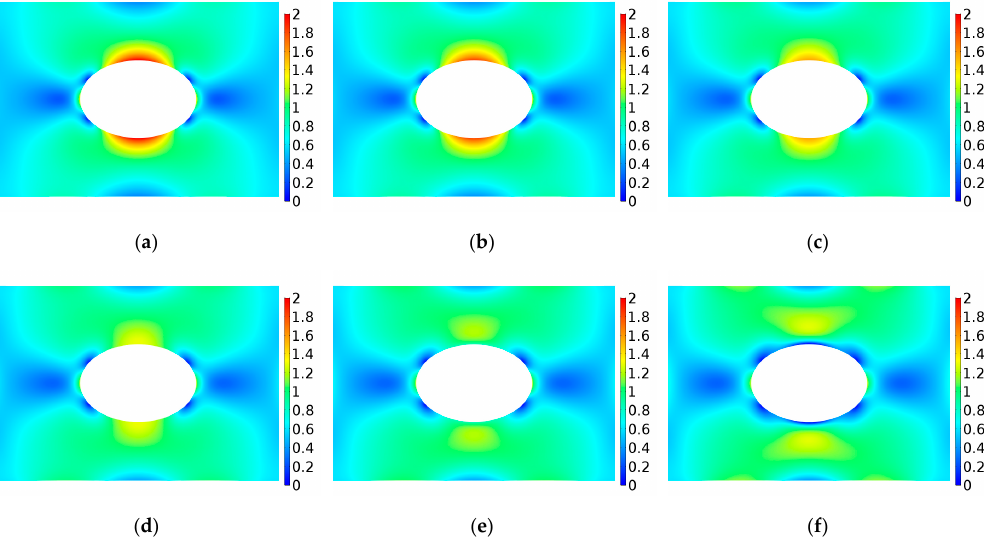
Figure 8. Variation of dimensionless Von Mises stress distribution for r-FGM when γ = − 0.5. ( a ) γ = − 0.5, c = 0.0; ( b ) γ = − 0.5, c = − 0.2; ( c ) γ = − 0.5, c = − 0.5; ( d ) γ = − 0.5, c = − 0.8; ( e ) γ = − 0.5, c = − 1.2; ( f ) γ = − 0.5, c = −